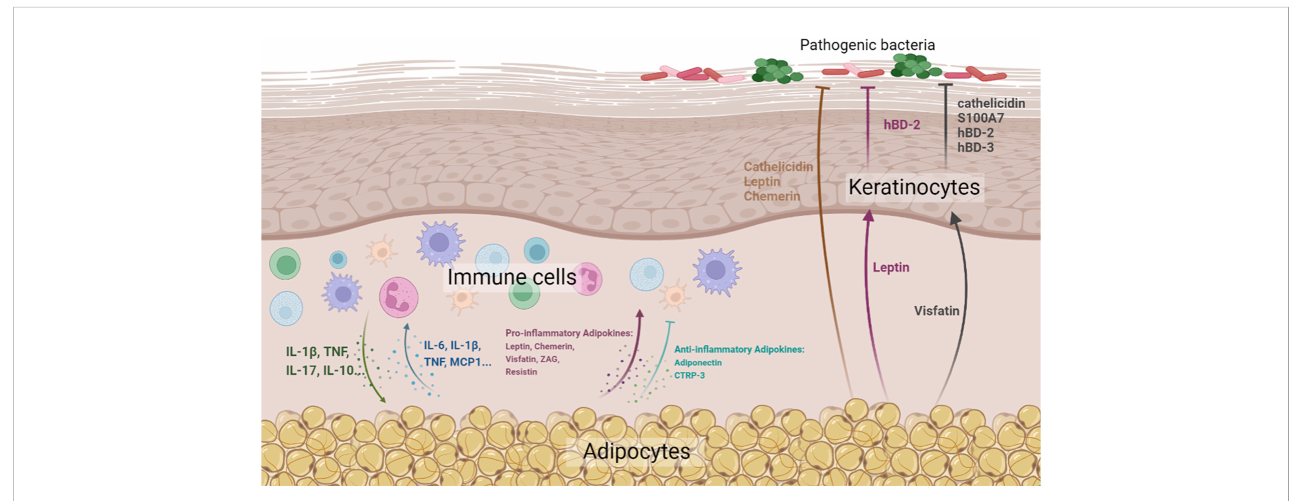
FIGURE 1 Diagrammatic representation of the effects of skin-associated adipocytes on skin barrier immunity (Created with BioRender.com. Agreement NO.